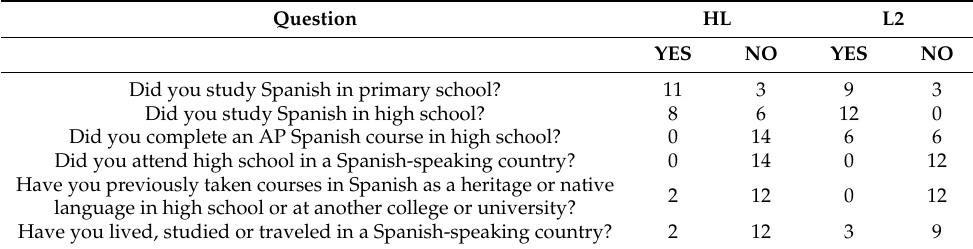
Table 1. Questions and number of YES/NO answers provided by students in the background